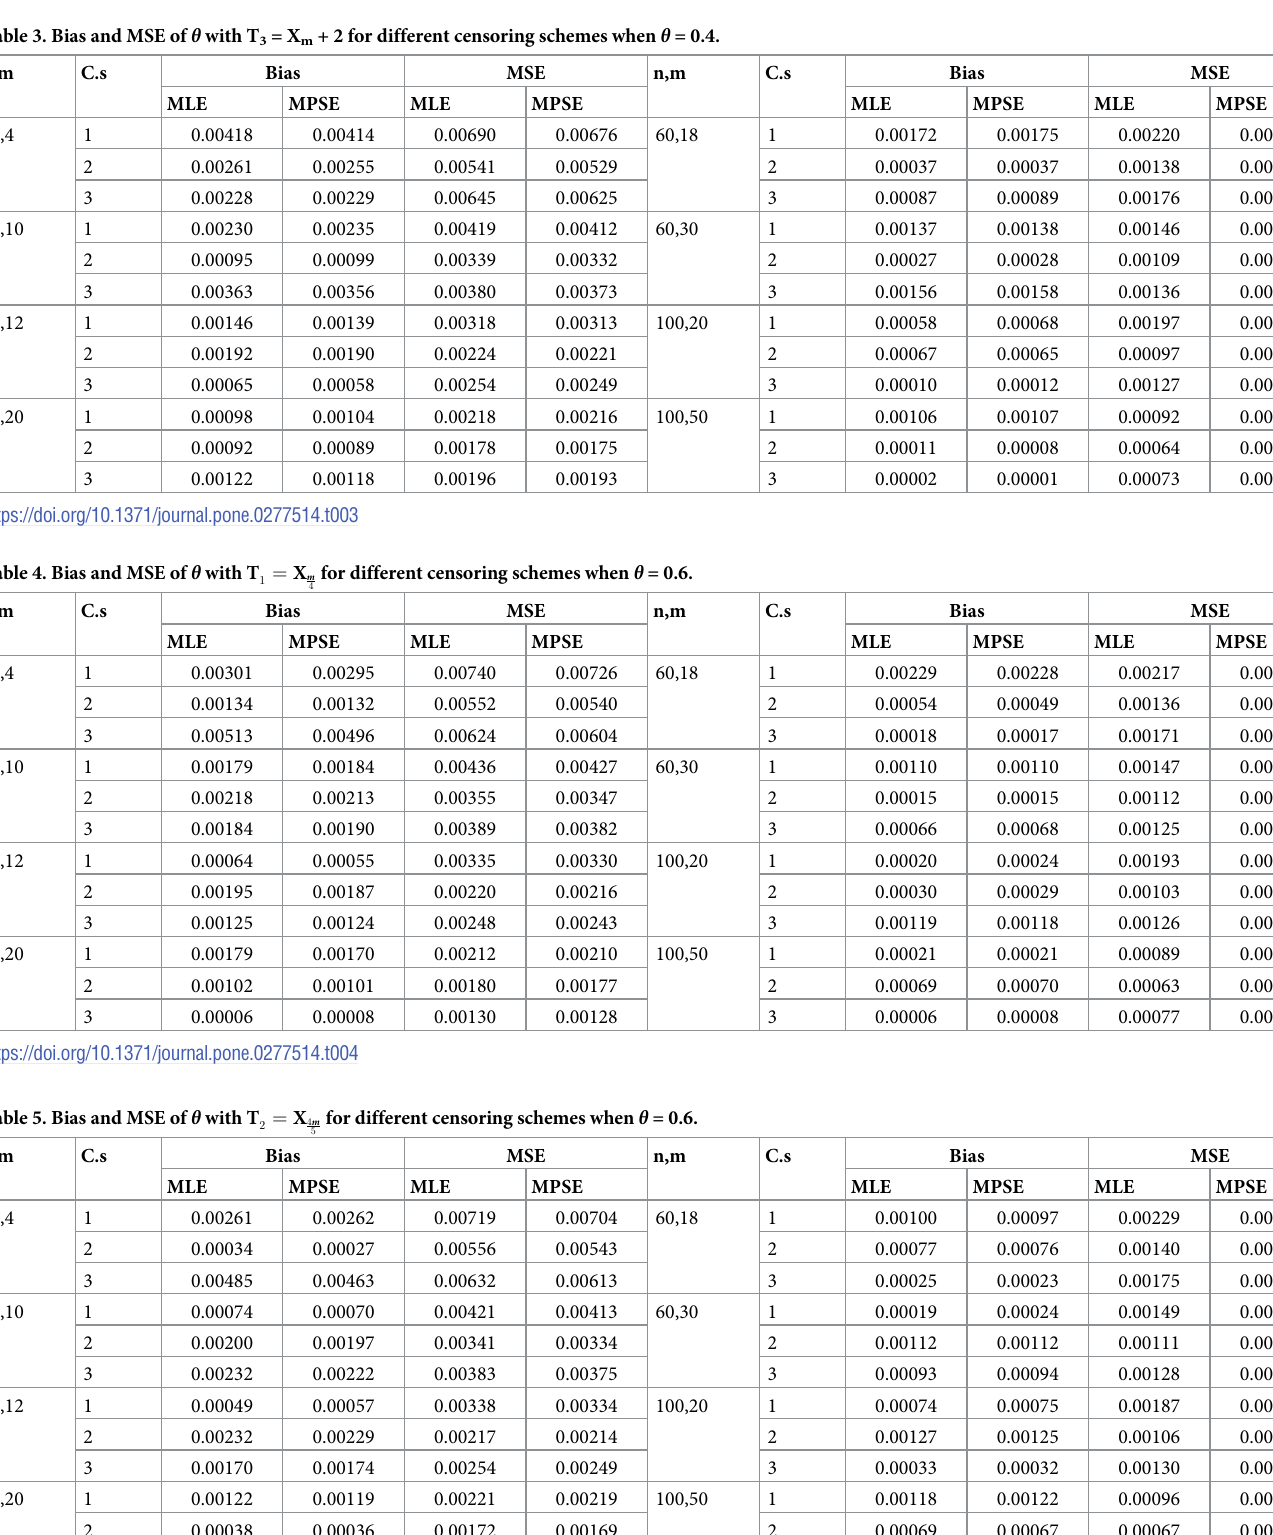
Table 3. Bias and MSE of θ with T 3 = X m + 2 for different censoring schemes when θ = 0.4.